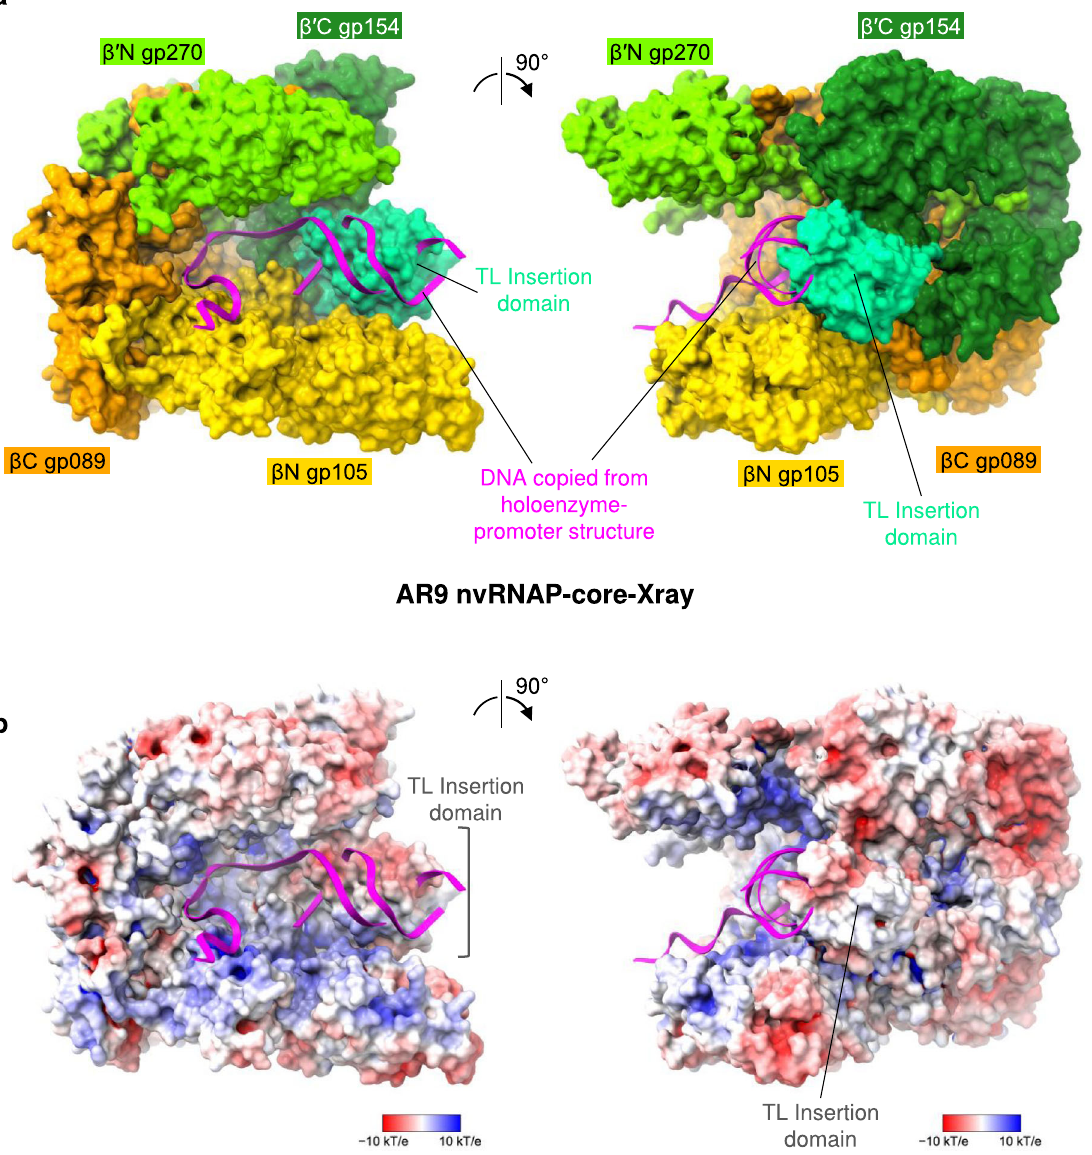
Fig. 4 Structure of the AR9 nvRNAP core. a Molecular surface of the AR9 nvRNAP core crystal structure (AR9 nvRNAP-core-Xray), with subunits colored as in Fig. 2a, with the downstream DNA oligonucleotide copied from the holoenzyme-promoter (AR9 nvRNAP-Pro-Xray) structure. The trigger loop insertion domain (TLID) partially obstructs the DNA binding cleft. b Electrostatic potential is mapped onto the molecular surface of the AR9 nvRNAP core. Both orientations are as in panel a